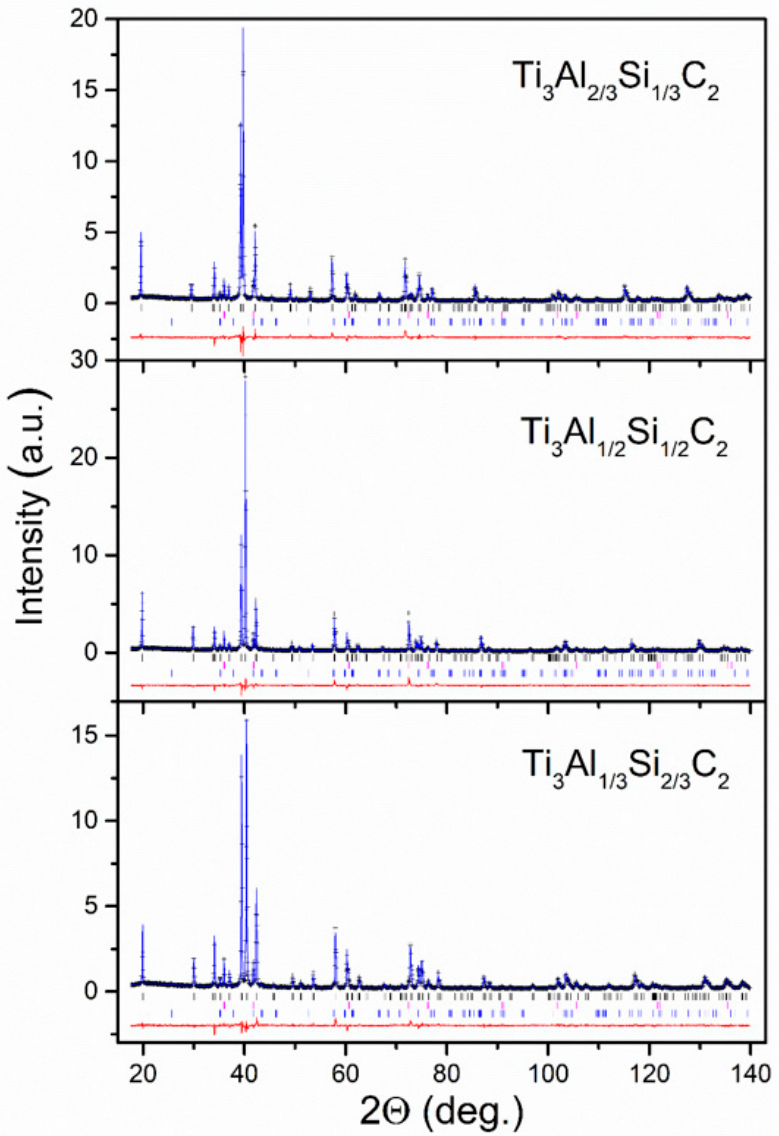
Figure 3. XRD patterns (black crosses) and the best-fit Rietveld refinement (solid blue lines) of the Ti 3 Al 1 − x Si x C 2 bulk sample (pellet). The rows of vertical bars below denote the Bragg peak positions for corresponding MAX phase (black), TiC (magenta), and Al 2 O 3 (blue) phases. The solid red lines represent the difference between the experimental and calculated patterns. Table 1. Mass contributions (%) of the phases obtained from the analysis of X-ray diffraction pat- terns of Ti 3 (Al 1 − x Si x )C 2 bulk samples with x = 0, 1/3, 1/2, 2/3, where Ti 3 (Al 1 − x Si x )C 2 is the majority